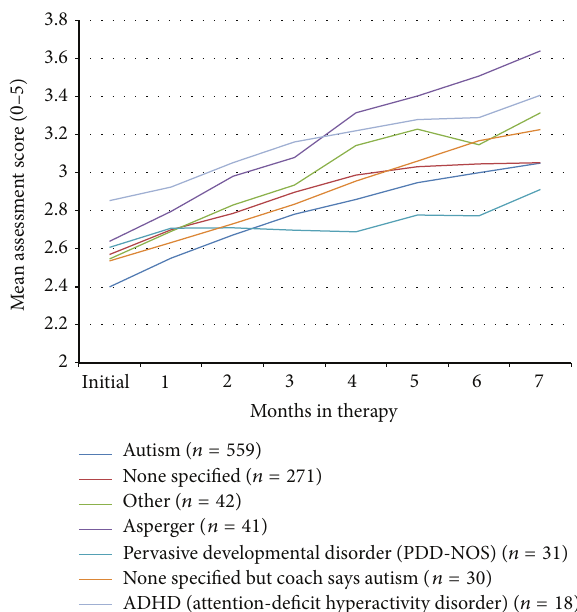
Figure 8: Mean composite assessment score (scale 0–5) over time for subjects with different reported